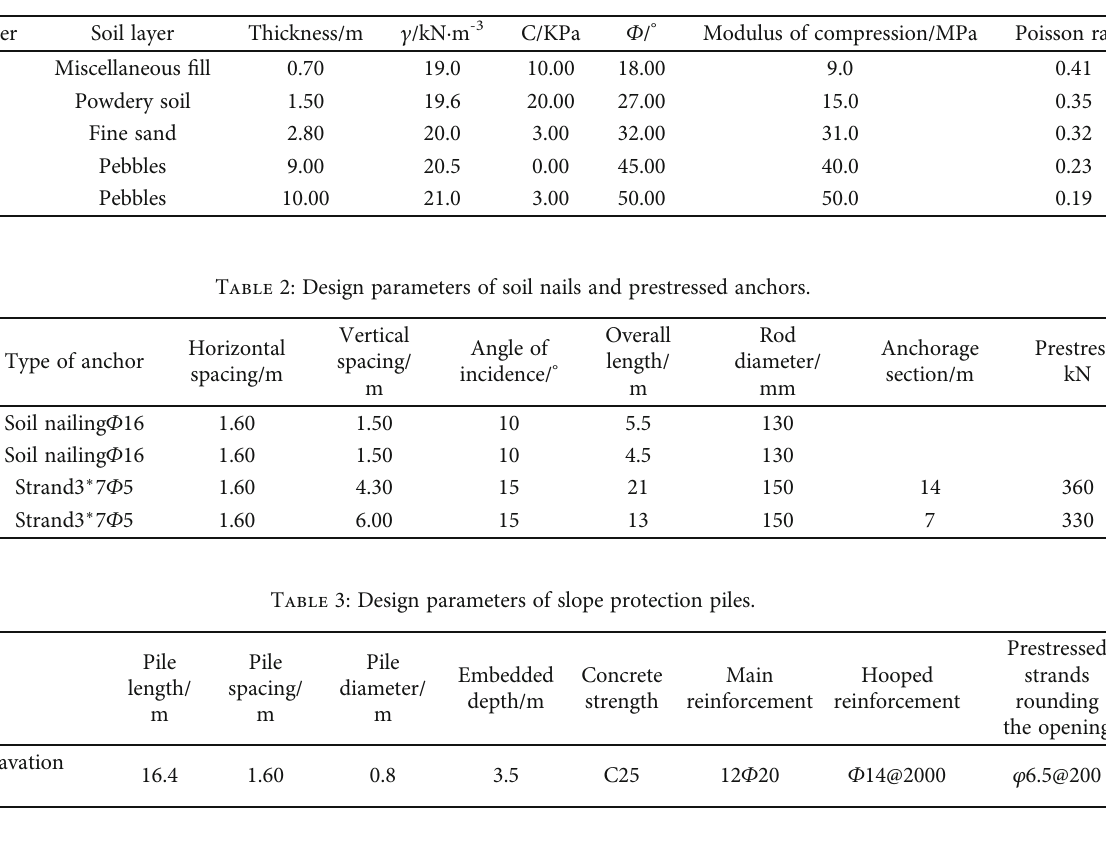
Table 1: Stratum physical and mechanical parameters.